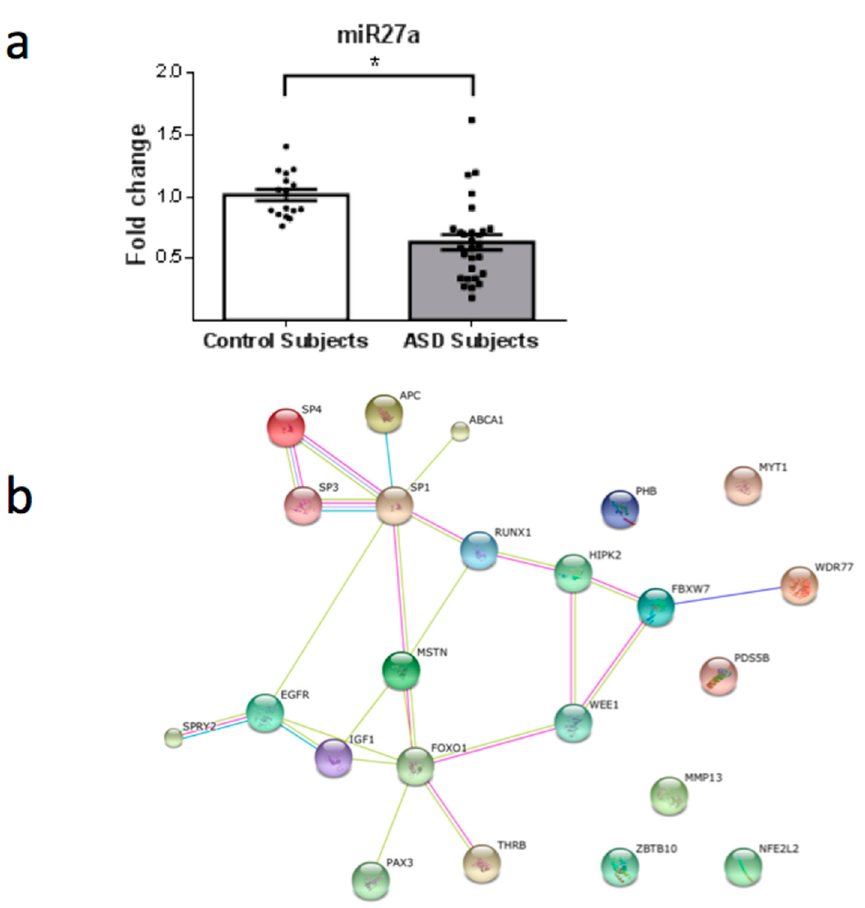
Figure 6. ( a ) Scatter plot of differential relative expression of miR27a in peripheral blood of ASD subjects compared to control subjects. Results expressed as mean ± standard error. t -Test analysis; * p < 0.05. ( b ) mRNA validates targets for miR27a selected in miRBase and respective proteins clusters that can be involved in ASD. Proteins involved in epigenetic regulation: SP4 (Sp4 transcription factor); SP3 (Sp3 transcription factor); WDR77 (WD repeat domain 77); RUNX1 (runt-related transcription factor 1); MYT1 (myelin transcription factor 1); SP1 (Sp1 transcription factor); FOXO1 (forkhead